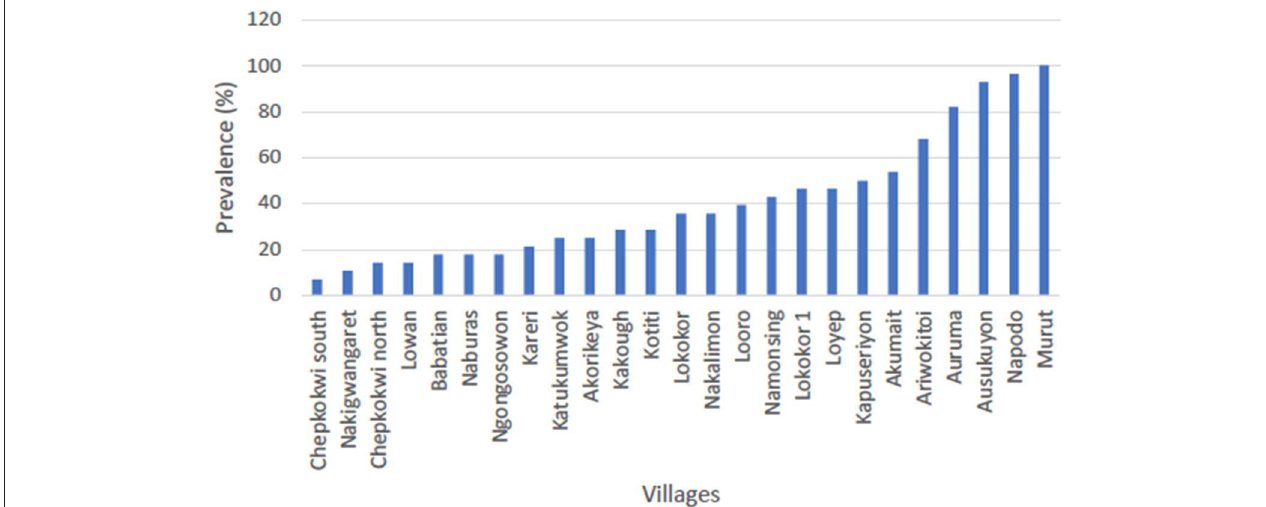
FIGURE 5 | Serosurvey result for the southern focus of transmission (Amudat). The average prevalence in Loroo subcounty was 40.7% with the highest seroprevalence being 100% in Murut village whereas the lowest was 7.1% in Chepkokwi south. More than half of the sampled villages (herds) had prevalence below